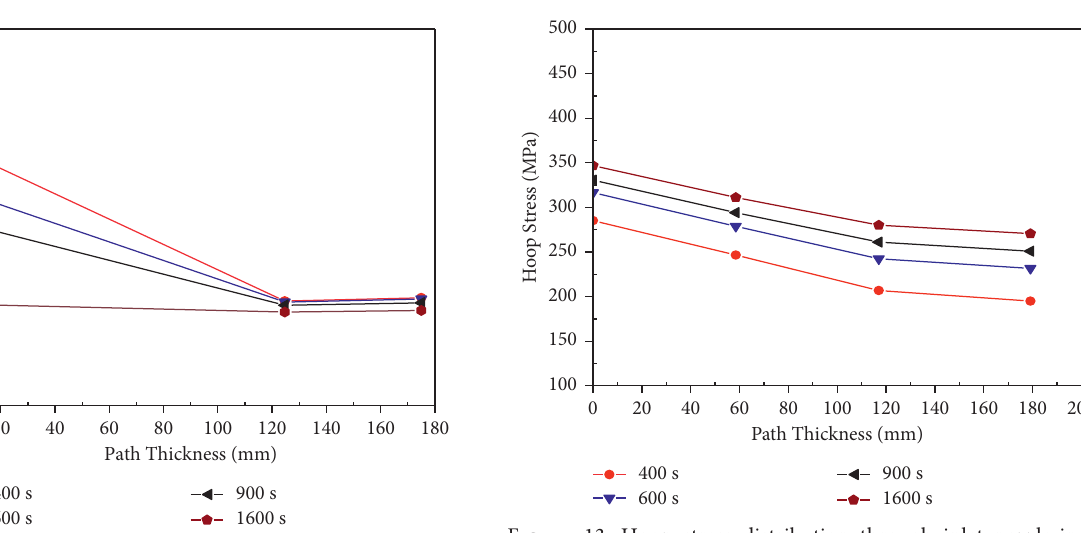
Figure 11: Heat flux distribution through the inlet nozzle-inner RPV wall intersection (path) thickness at different times.